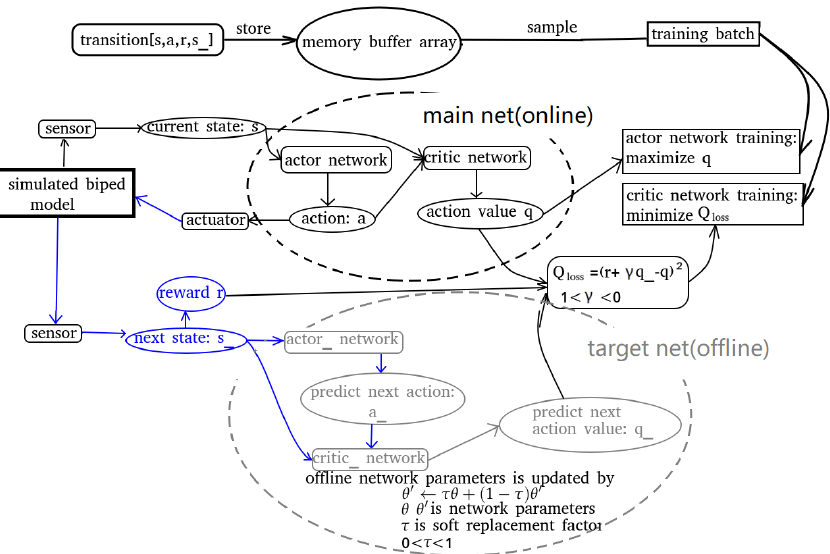
Figure 4. The critic and actor networks (evaluate/target) both have two hidden layers; the first layer has 400 neurons and the second layer has 300 neurons. The activation function is a rectified linear unit (ReLU). The output of the actor network goes through a tanh activation function. The network has a memory of 70,000 steps and the training begins when 20,000 transitions are stored. The learning rate of the actor and critic are set to 10 − 8 and 2 × 10 − 8 , respectively. The reward discount γ is set to 0.99, and the training batch is 100